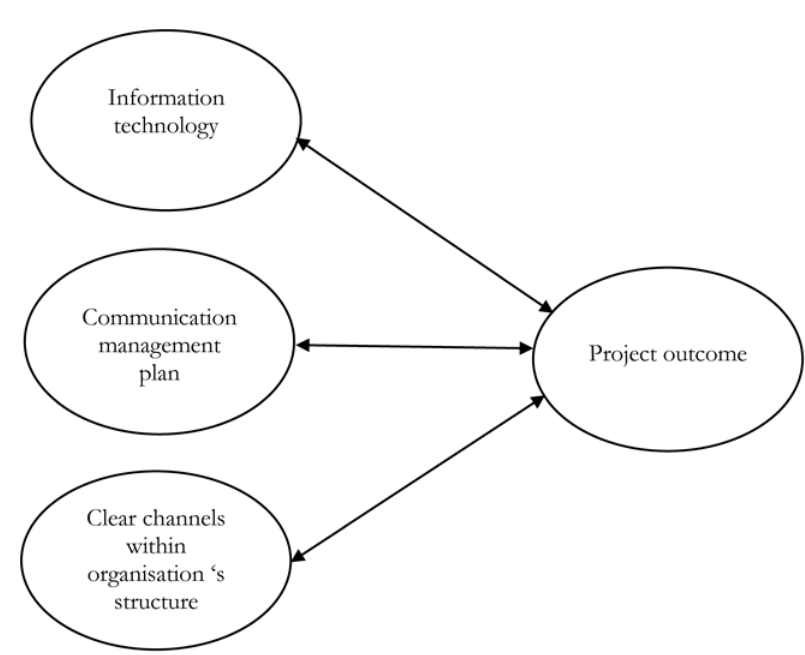
Figure 1 Empirical relationship between the communication management practices and project